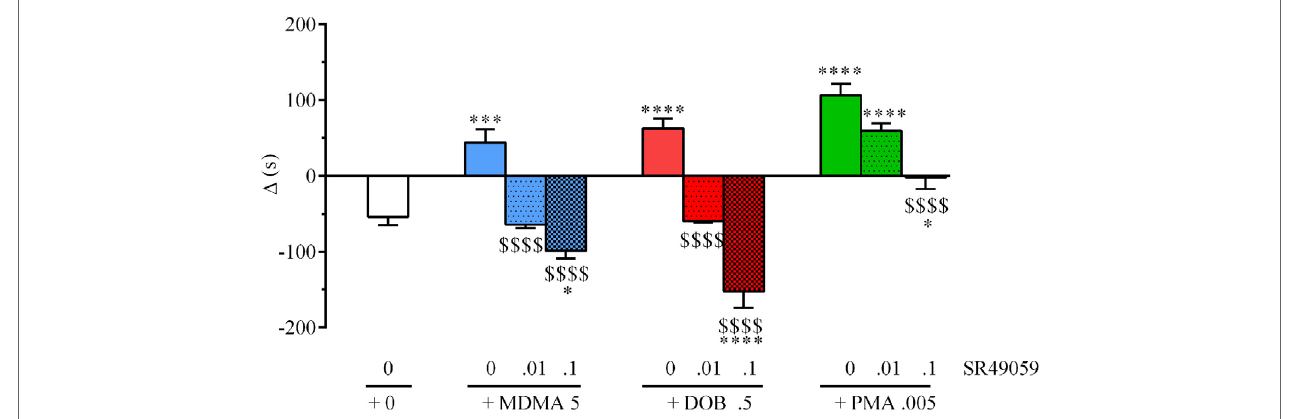
FigUre 3 | SR49050 blocks 3,4-methylenedioxymethamphetamine (MDMA)-, 2,5-dimethoxy-4-bromo-amphetamine hydrobromide (DOB)-, and para - methoxyamphetamine (PMA)-induced conditioned place preference (CPP). Mean values ± SEM of differences in the time spent (s) by each zebra fish in the drug-paired compartment before and after conditioning. Each drug (mg/kg) plus SR49059 (ng/kg) or vehicle was administered intramuscularly (IM) immediately before the conditioning session. n = 10 fish per group. * p < 0.05, ** p < 0.01, *** p < 0.001 vs. the vehicle group (0 + 0); $ p < 0.05, $$$ p < 0.001 vs. the corresponding drug alone (Tukey’s post hoc